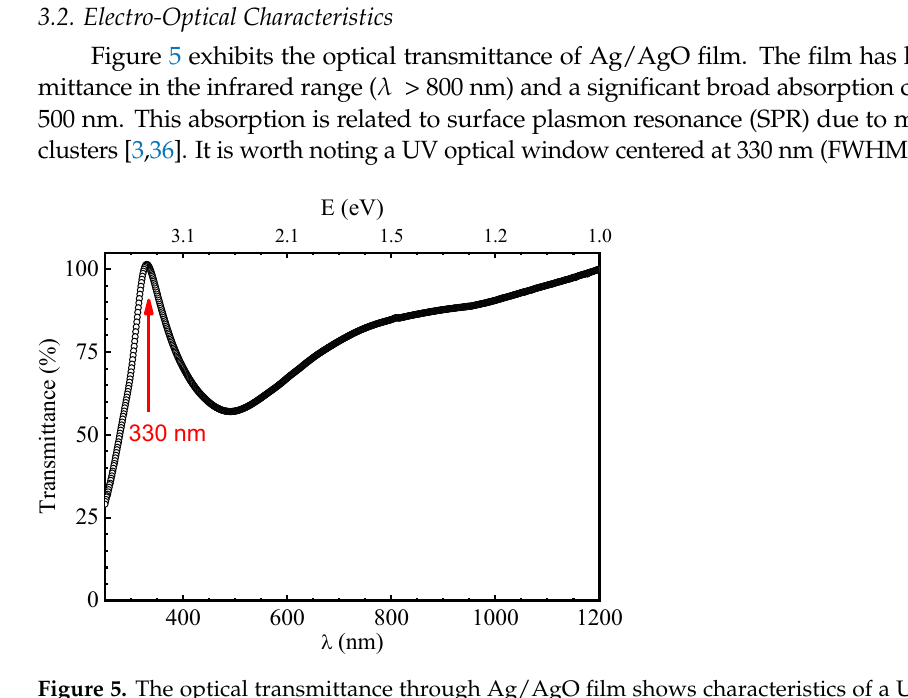
Figure 5. The optical transmittance through Ag/AgO film shows characteristics of a UV window with the coexistence of optical effects due to metallic Ag, such as the SPR absorption around 500 nm.